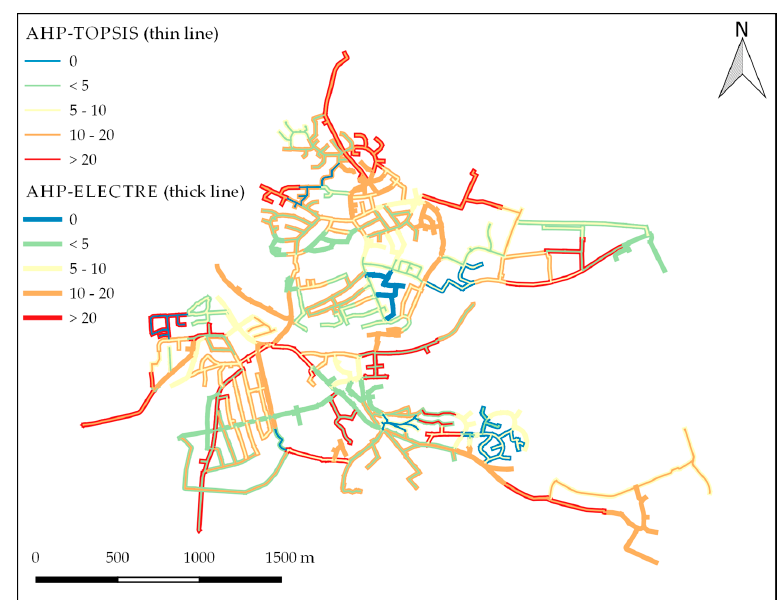
Figure 10. Comparison of the rankings of the water distribution system between TOPSIS (thin line) and ELECTRE (thick line) with the results from AHP.